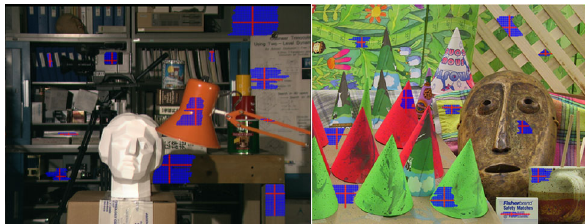
Figure 3. Examples of regions formed with the linear approach for the generation of cross-based